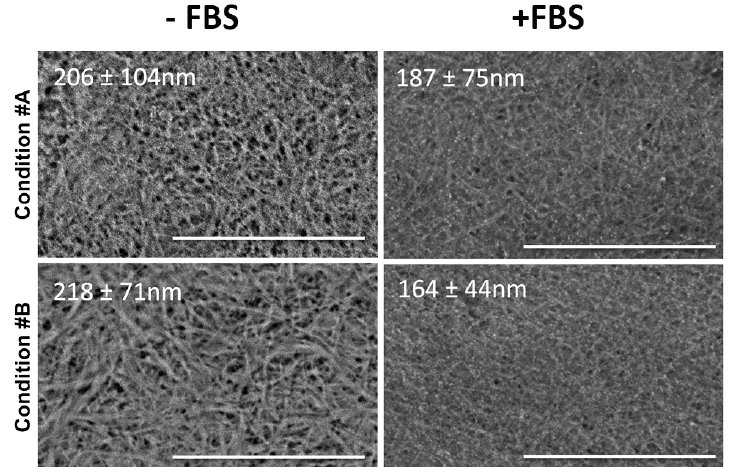
Figure 3. Cont. Figure 3.